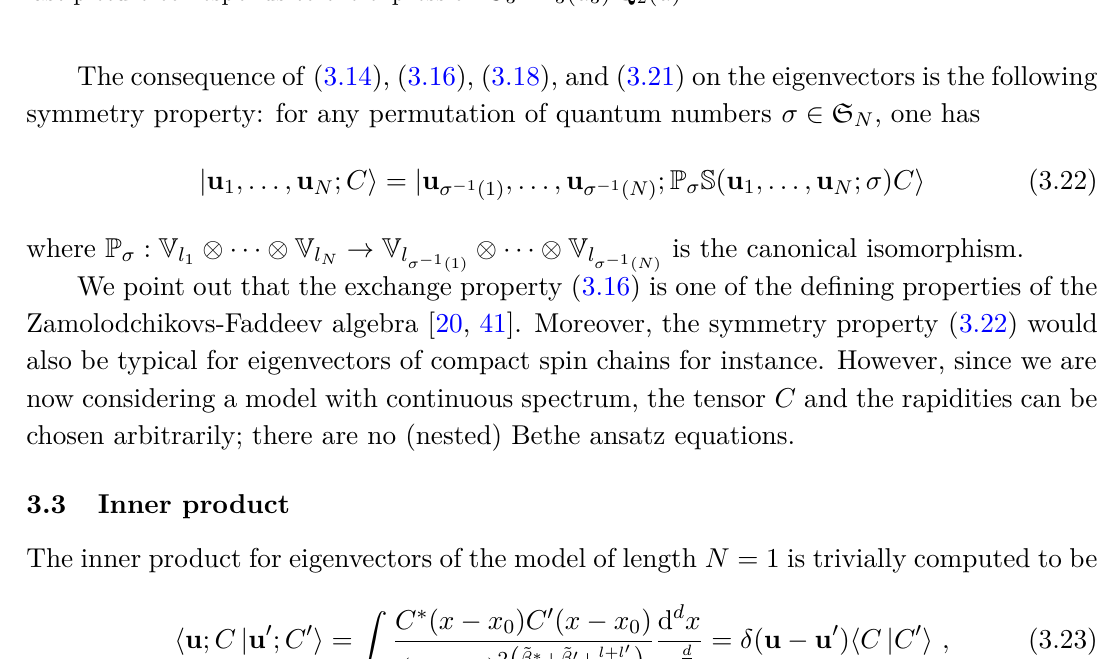
Figure 14 . Last step of the diagonalisation procedure: in order to pass from the first to the second drawing, the vertical lines with indices δ have been moved to the right. The upper two were moved using star-triangle and chain relations, whereas the lower one is moved using property (A.5). The last picture corresponds to the expression C 3 · Λ 3 ( u 3 ) Q 2 ( u )